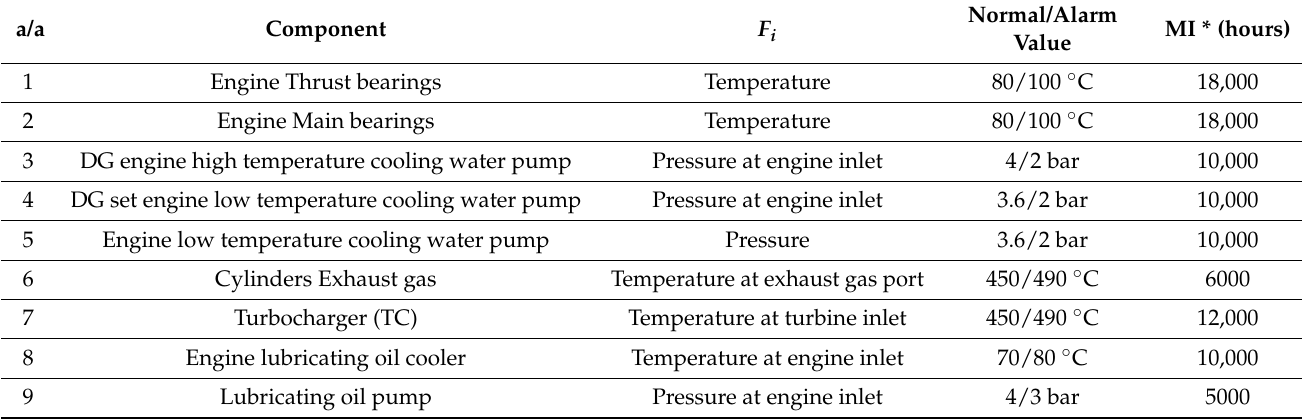
Table 4. Selected features for the identified critical components of the investigated cruise ship power plant